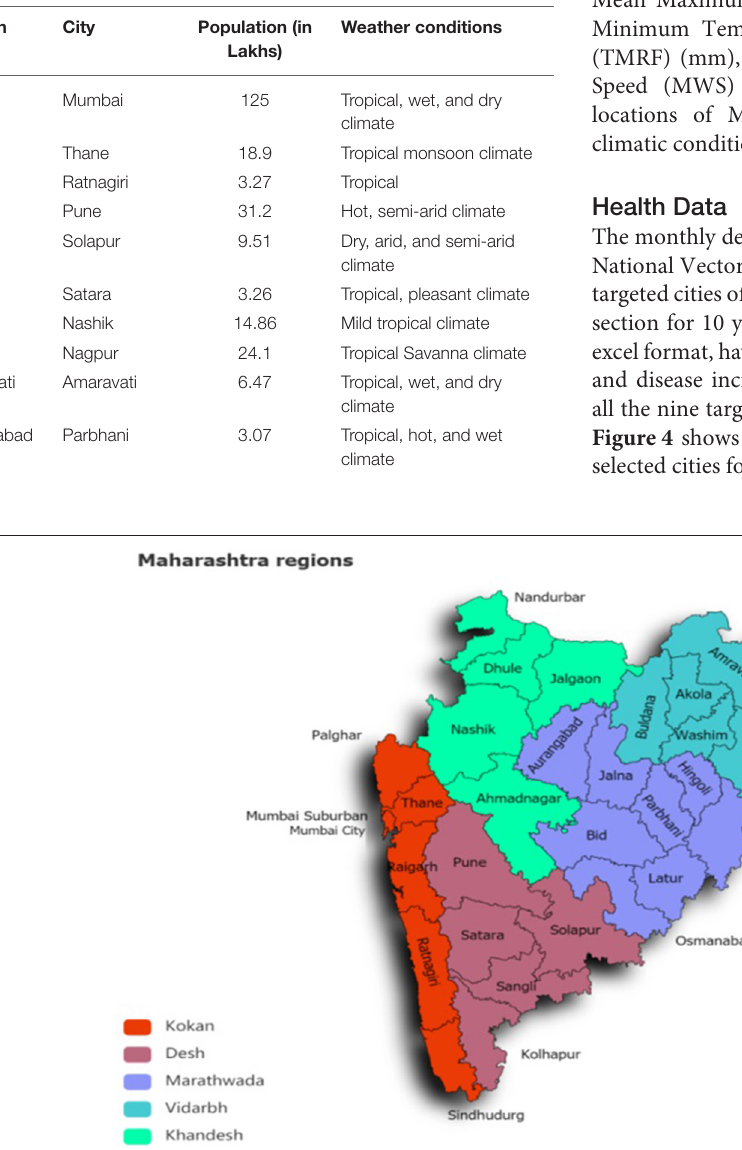
FIGURE 4 | Map of Maharashtra state with region wise selected cities.